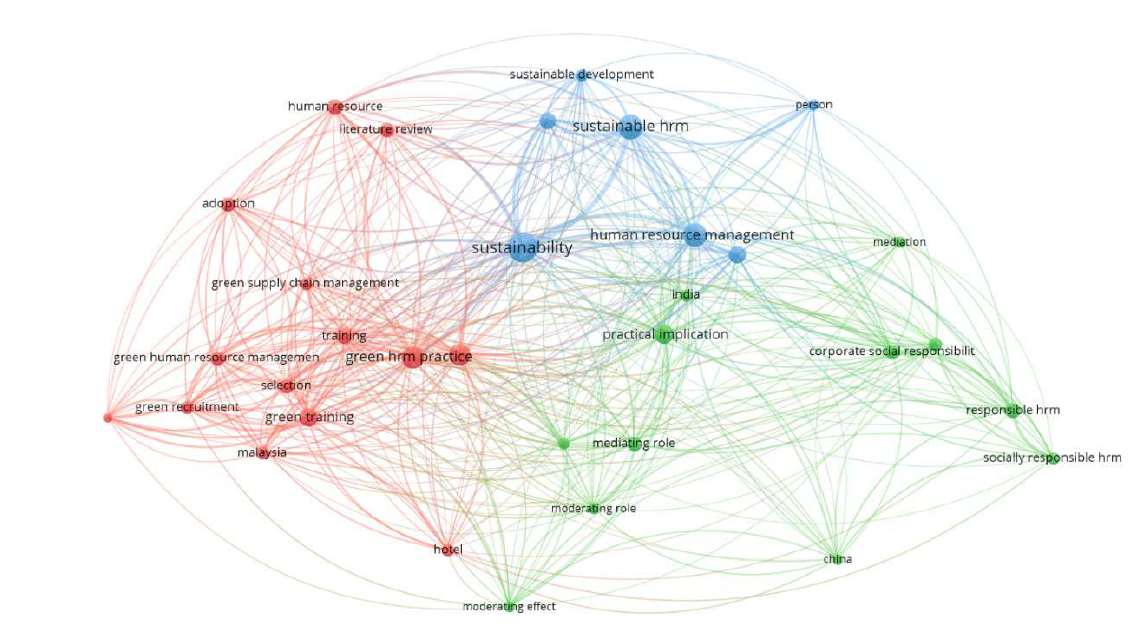
Figure 5. Term co-occurrence analysis of sustainable HRM research